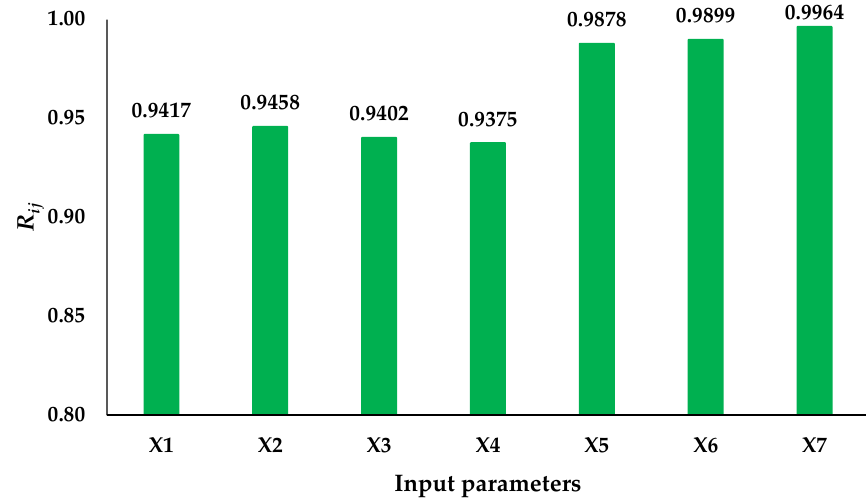
Figure 5. Relative strength effect of input parameters in predicting R-value.